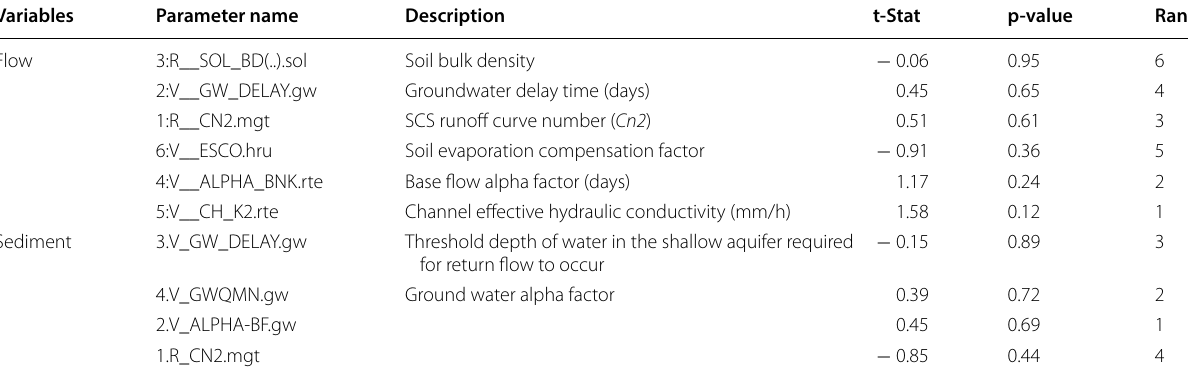
Table 2 Summary of global sensitivity analysis